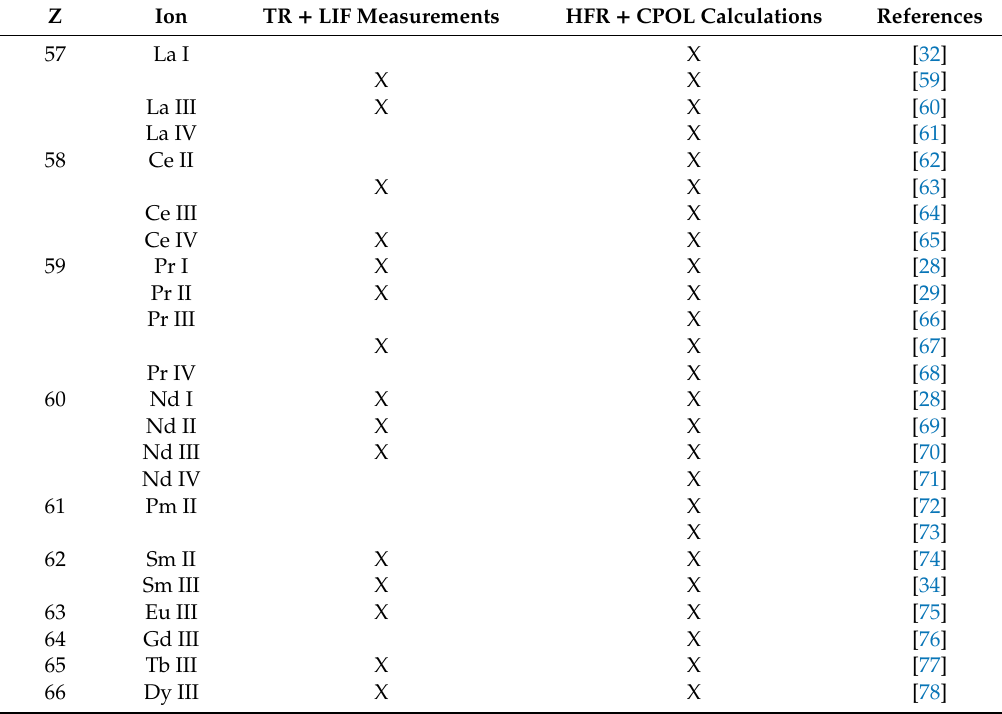
Table 1. Experimental and theoretical methods used in our work for the determination of radiative parameters in lanthanide elements ( Z = 57–71) and related